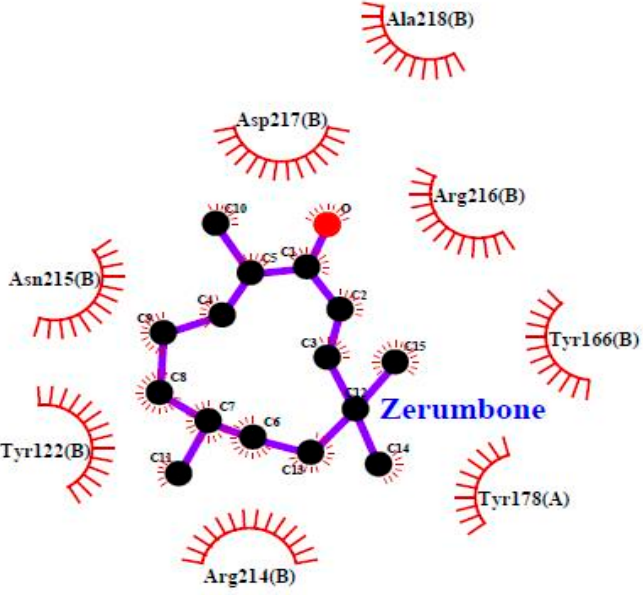
Figure 7. Zerumbone in complex with integrin α v β 3 (Protein Data Bank (PDB) code: 1L5G).